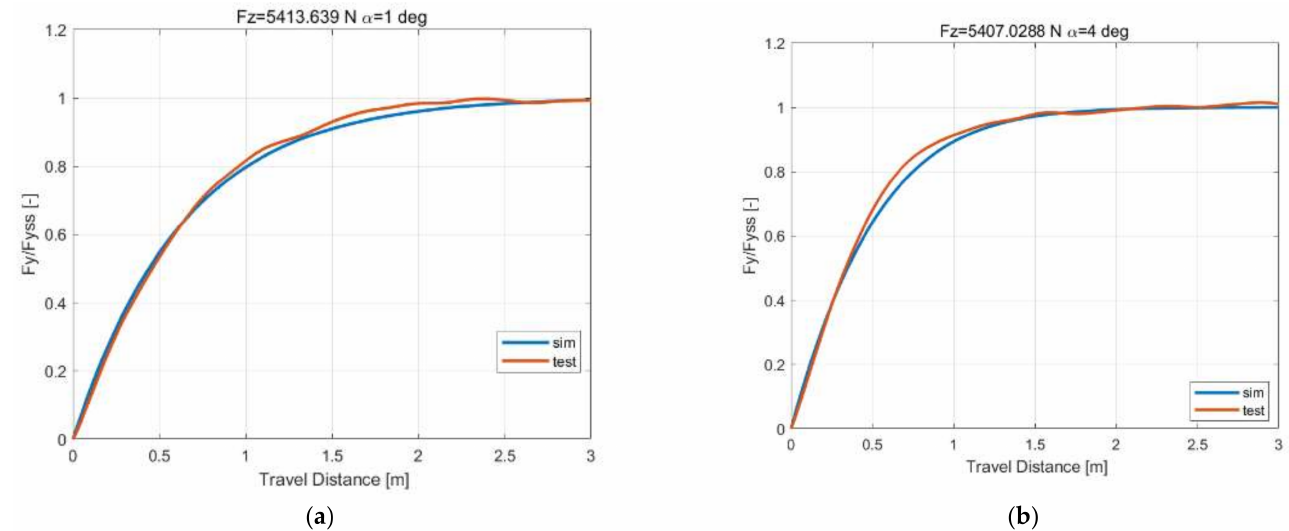
Figure 10. Step side slip angle comparison between model and test. ( a ) Side slip angle = 1 deg; ( b ) Side slip angle = 4